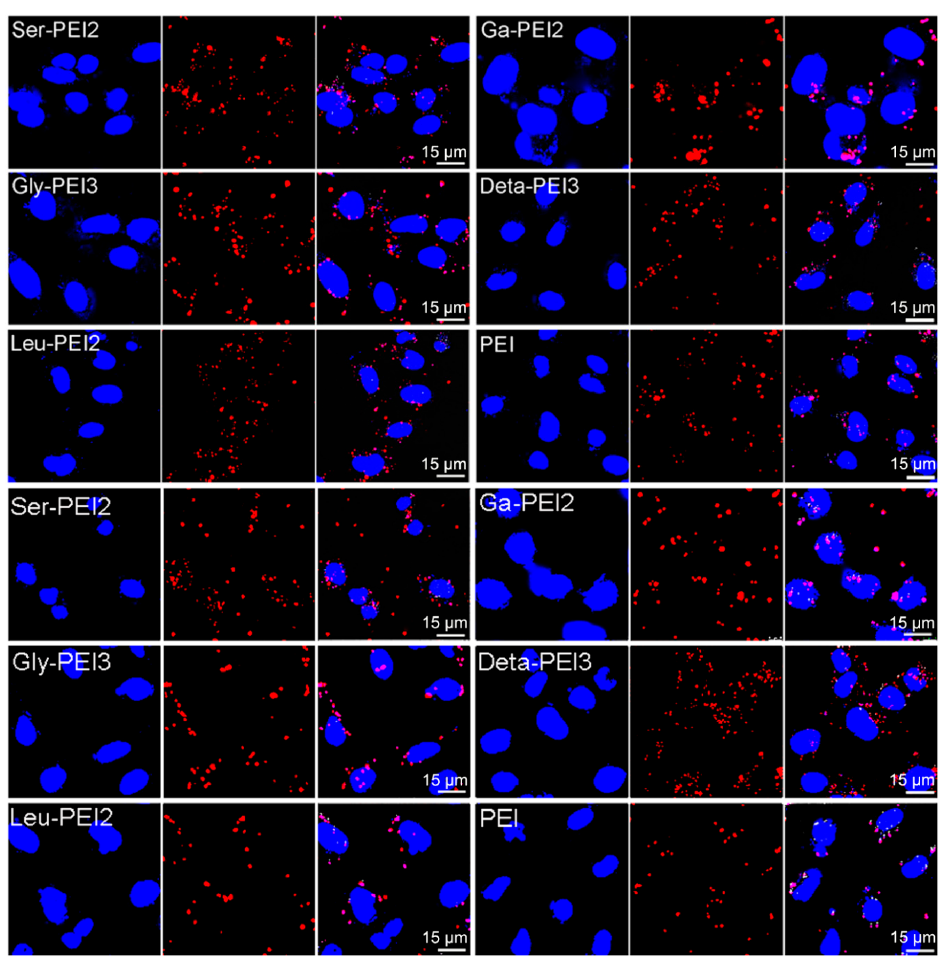
Figure 10. CLSM images of U-2OS cells transfected with Cy5-labelled DNA by polymers at their respective optimal weight ratio in the absence (upper) and presence (lower) of serum. PEI as control ( w / w = 1.4, N/P = 10). For each triad image, left: cell nuclei stained by DAPI (blue); middle: Cy5-labeled pDNA (red); right: merged image.